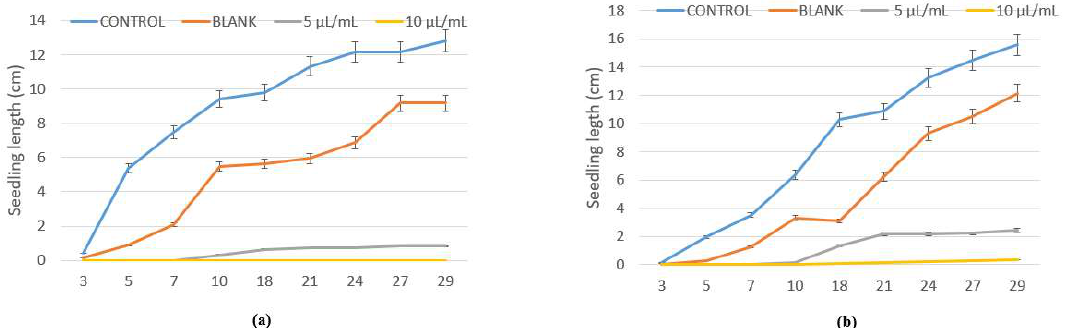
Figure 4. Hypocotyl growth (cm) of ( a ) L. multiflorum and ( b ) E. crus-galli control and blank, and treated with winter savory essential oil at 5 and 10 µL/mL.